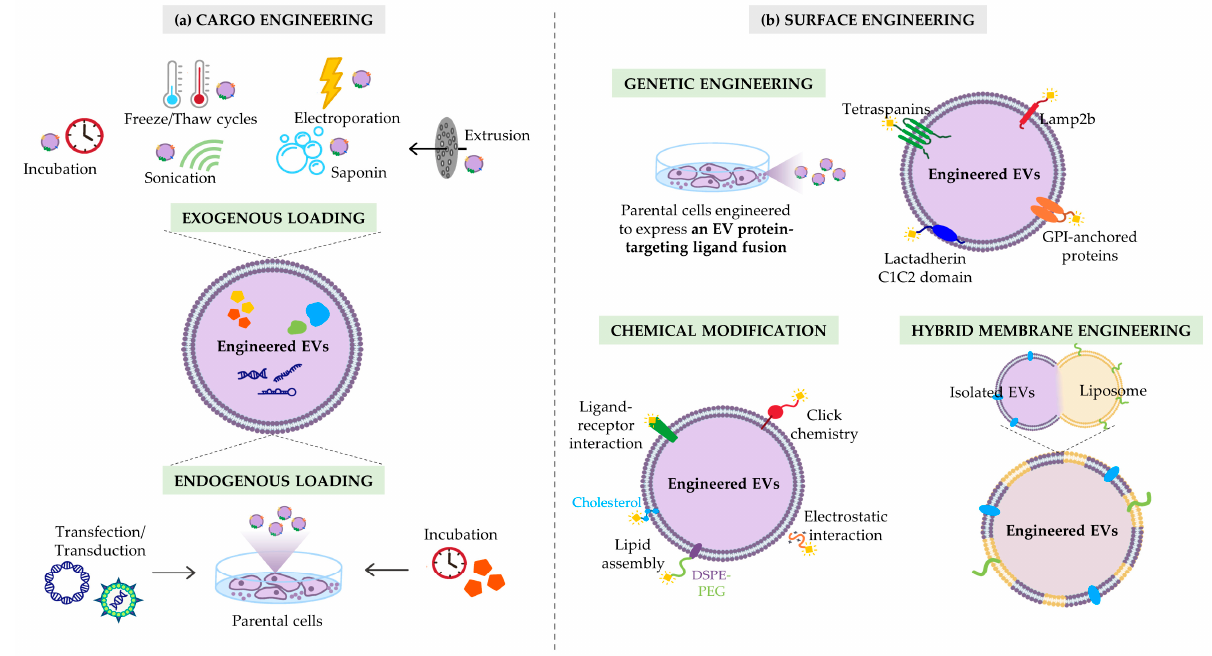
Figure 2. Strategies to maximize the therapeutic e ffi cacy of extracellular vesicles (EVs). ( a ) Cargo engineering of EVs by exogenous/direct loading, through external incorporation of cargo into isolated EVs, or endogenous/indirect loading, by providing the parental cells with the means to naturally incorporate the desired cargo during EV biogenesis. ( b ) Surface engineering of EVs: The parental cells can be genetically engineered to produce EVs displaying transmembrane protein- targeting ligand fusions. The isolated EVs can be chemically modi fi ed, by anchoring targeting moieties to the surface of isolated EVs through covalent bonds, lipid self-assembly or other non-covalent reactions. Hybrid membrane engineering allows the fusion of isolated natural EVs and synthetic liposome nanoparticles. DSPE—1,2-distearoyl-sn-glycero-3-phosphoethanolamine; GPI—glycosyl-phosphatidylinositol; Lamp—lysosomal-associated membrane proteins; PEG—polyethylene glycol.